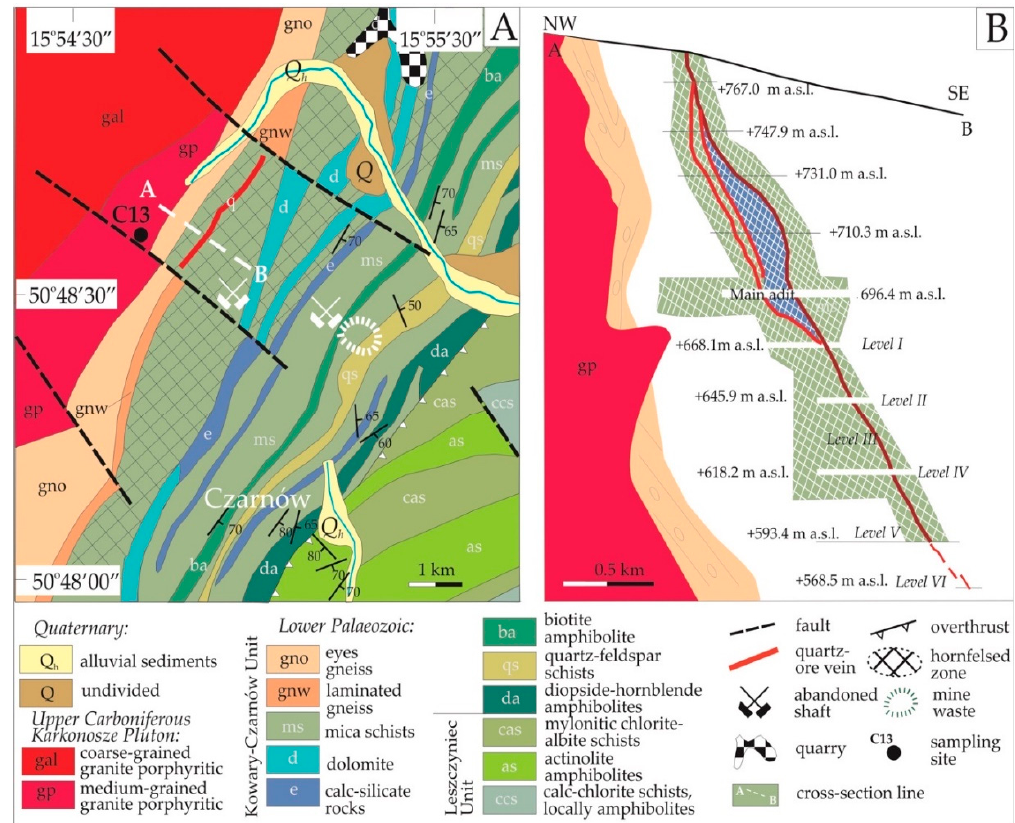
Figure 5. ( A ) Geological map of the Czarnów deposit area with location of the sampling site (C13) after [77]; ( B ) Schematic geological cross-section through the Czarnów As-polymetallic deposit.